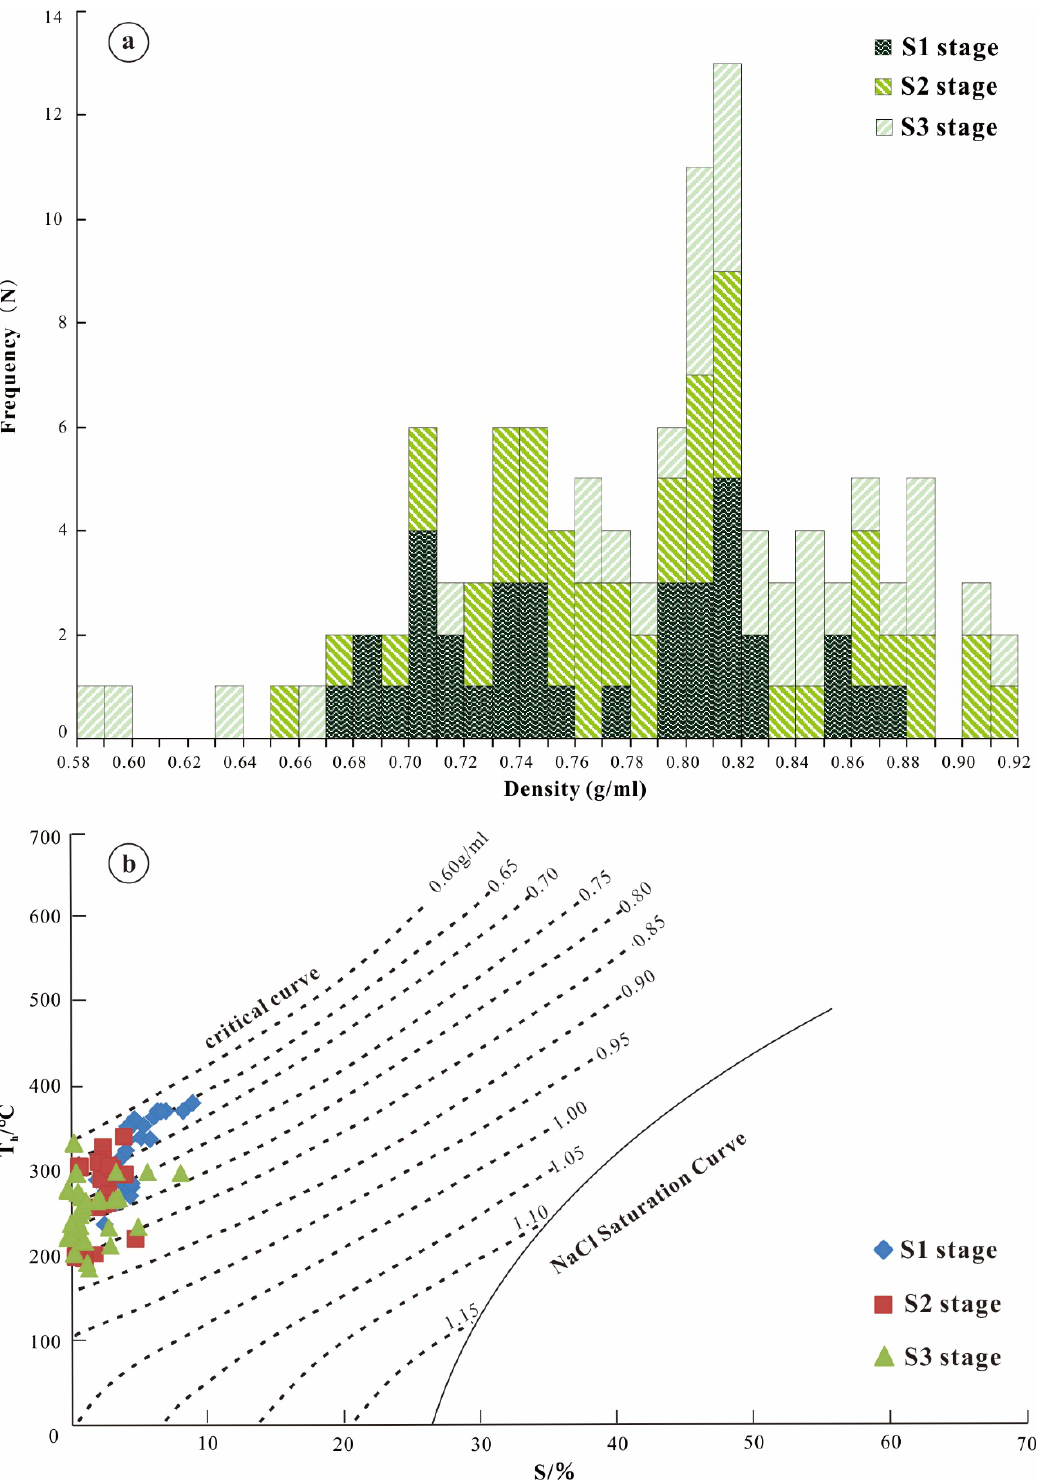
Figure 10. ( a ) Fluid density histogram of Hongqiling Sn-W polymetallic deposit; ( b ) phase diagram of Th-salinity-density in NaCl-H 2 O system.